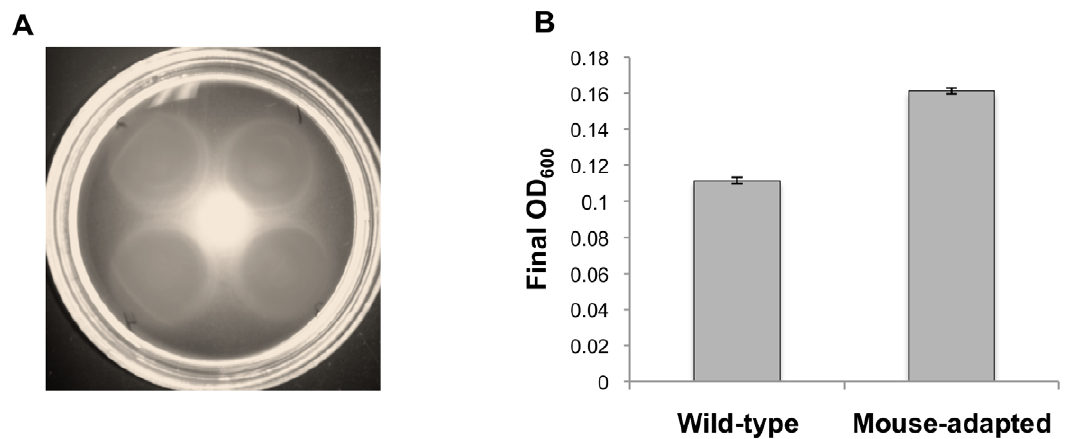
Figure 3. Invitro phenotypes of mouse-adapted C.jejuni . (A) Soft agar plates allow motile C. jejuni to spread from the center of inoculation. The ability to spread is based on flagellar motility. The top right spot is the wild-type variant and shown going clockwise are mouse-adapted variants passaged one, two, or three times through mice. All have spread an equal amount after 48 hours. (B) A higher final OD 600 for the mouse-adapted variant indicates a decreased ability to autoagglutinate. Standard error bars are shown.